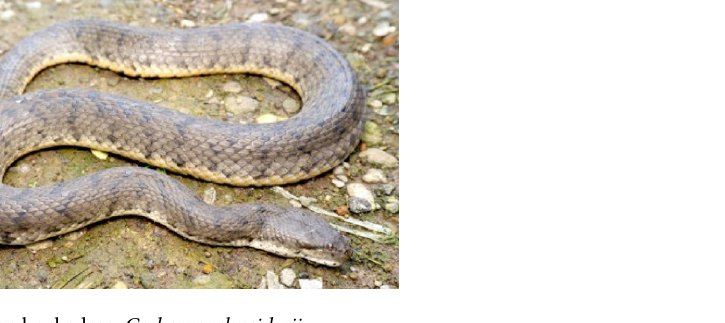
Figure 1. The Asian bockadam, Cerberus schneiderii